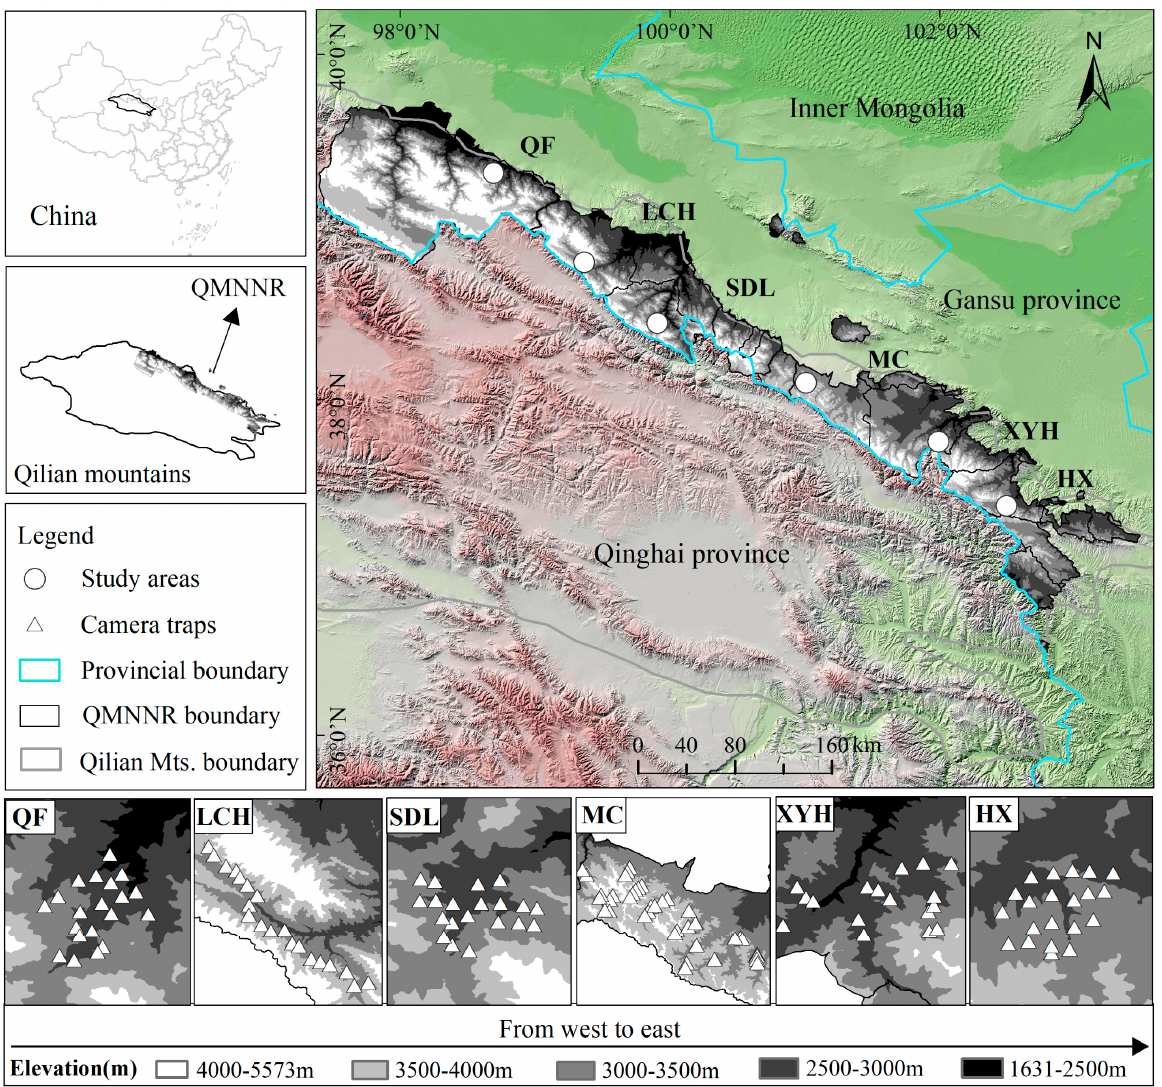
Figure 1. Camera–trap site distributions in six study areas (Qifeng, QF; Longchanghe, LCH; Sidalong, SDL; Machang, MC; Xiyinghe, XYH, and Haxi, HX) in the QMNNR, Northwestern China. (Available online for the map layer of Altitude and Remote Sensing Image: www.gscloud.cn/ accessed on 12 April 2021).